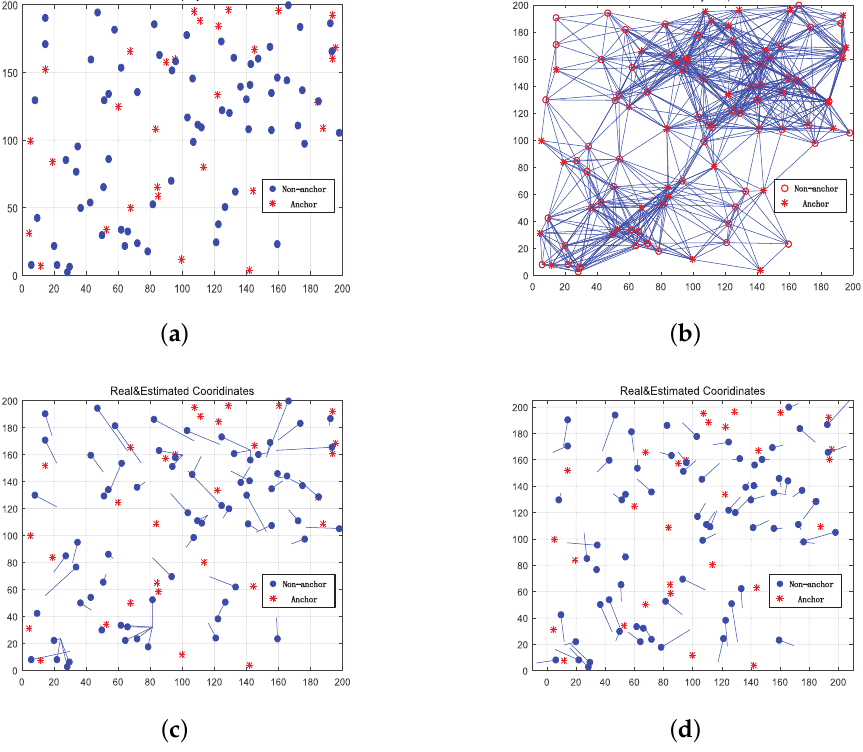
Figure 5. Localization results of DV-Hop and DV-CWDD: ( a ) node deployment, ( b ) connectivity graph, ( c ) DV-Hop, ( d )